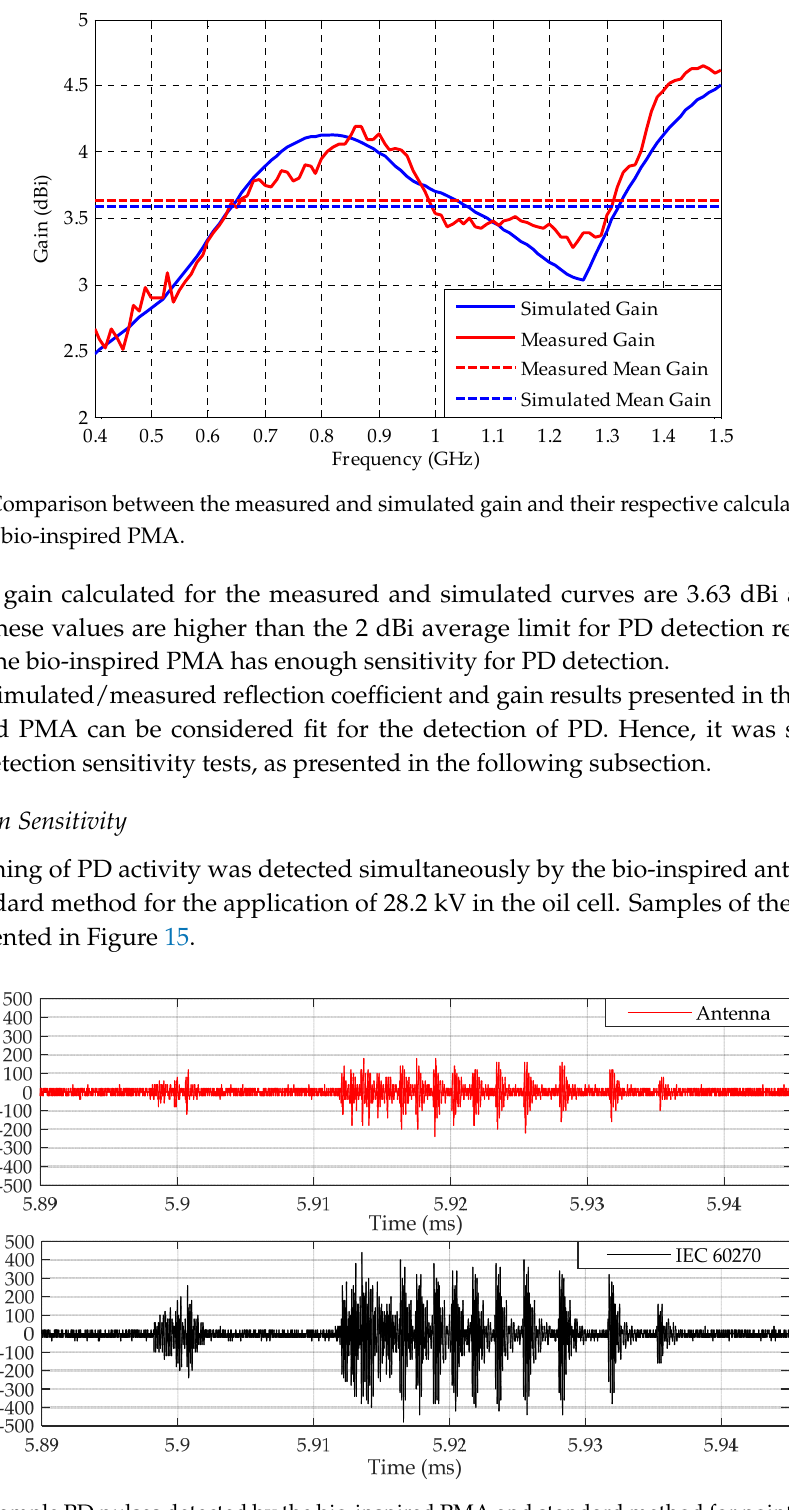
Figure 13. PMA bio ‐ inspired electric current distributions: ( a ) 350 MHz; ( b ) 900 MHz; (c) 1500 MHz. Using the procedures exposited in the previous section in an anechoic chamber, the bio ‐ inspired PMA gain was measured. The comparison between the measured and simulated gain is presented in Figure 14.